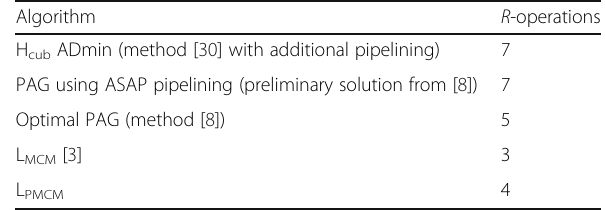
Table 4 Resulting R -operations for Example 2 using n = 2